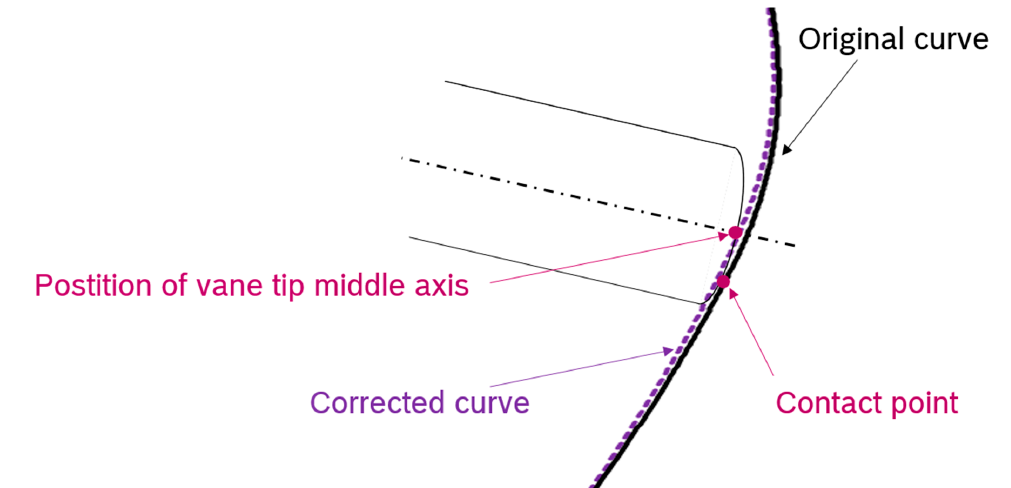
Figure 6. Original cam ring curve and corrected curve for vane motion.